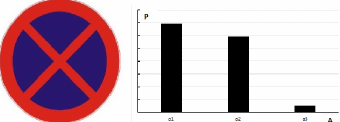
Figure 1: The Histogram of Standard Traffic Sign